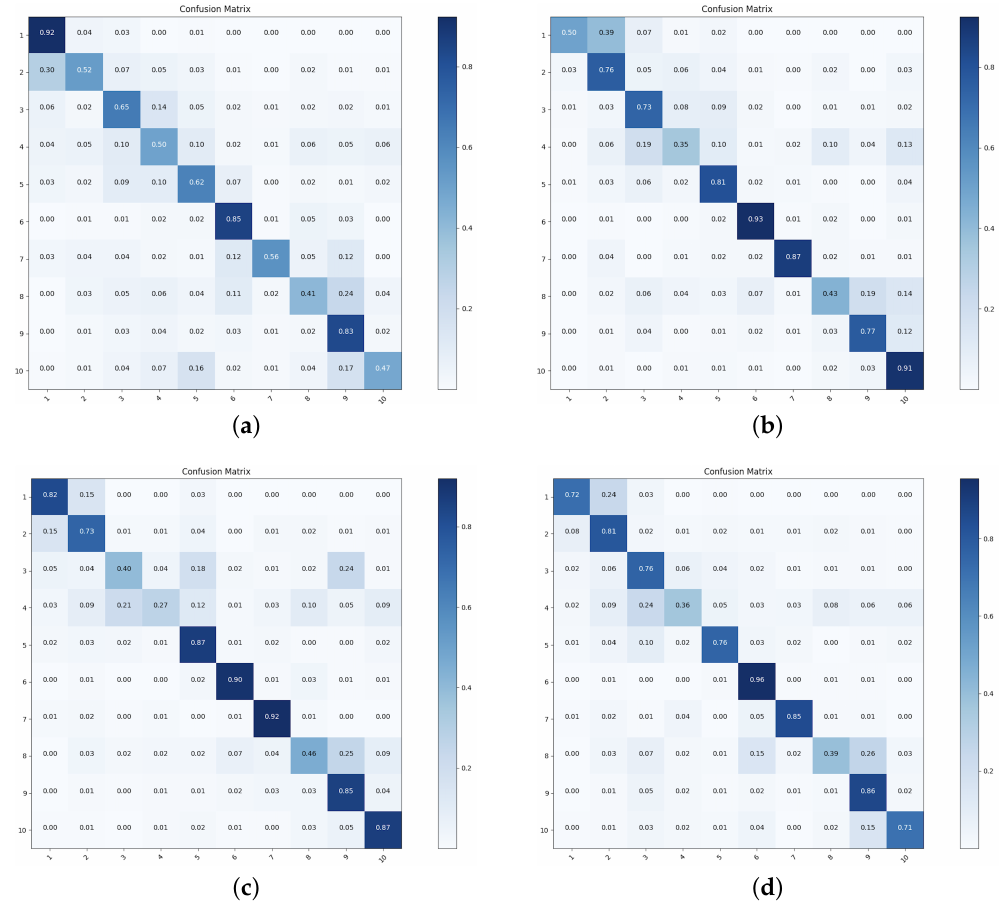
Figure A4. Confusion matrix computed over the test dataset for every method for 10 semantic LULC classes. ( a ) Confusion matrix for ConvLSTM-S1. ( b ) Confusion matrix for ConvLSTM-S2. ( c ) Confusion matrix for ConvLSTM-S1S2. ( d ) Confusion matrix for